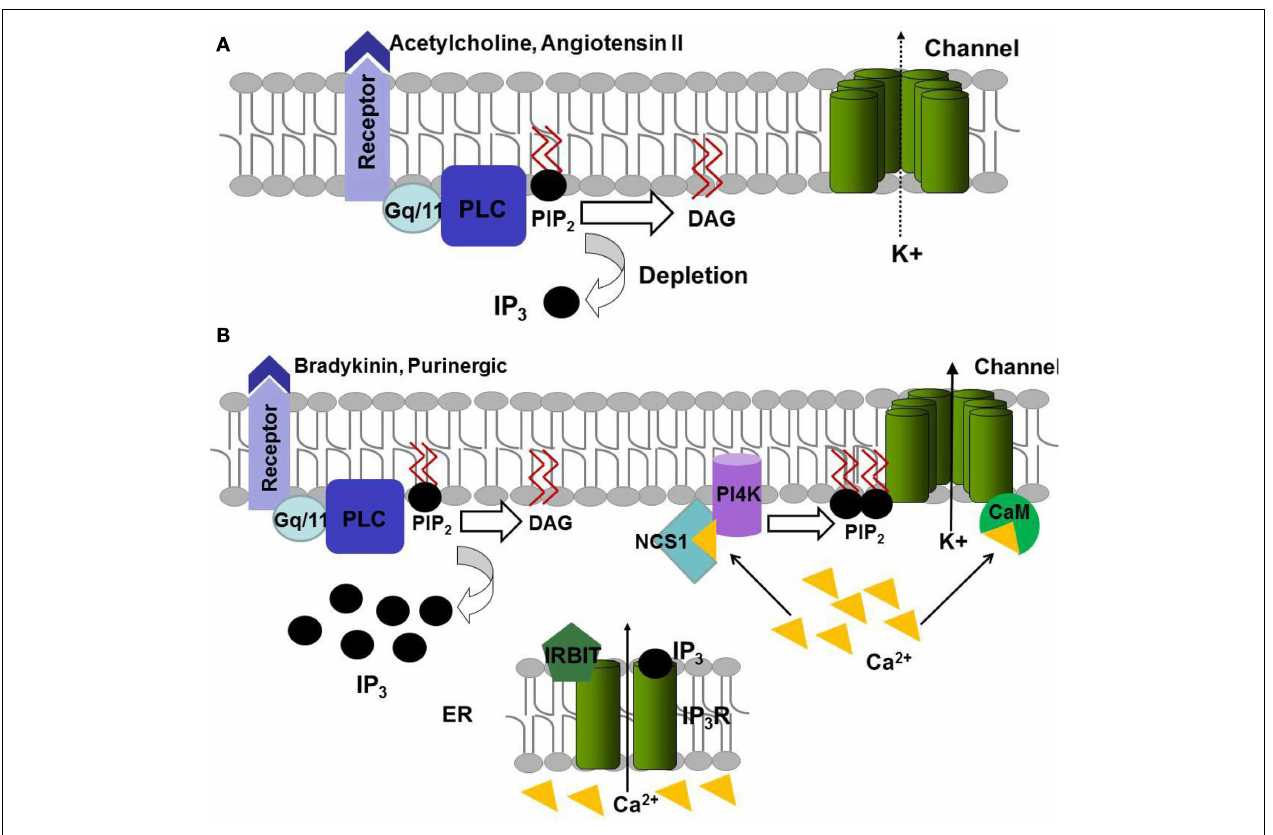
re-synthesis. IP 3 allows releasing Ca 2 + from endoplasmic reticulum via IP 3 R receptor.The released Ca 2 + can bind to NCS-1 that induces the synthesis of PIP 2 via PI4K or bind to CaM and modulate the channel sensitivity to PIP 2 .